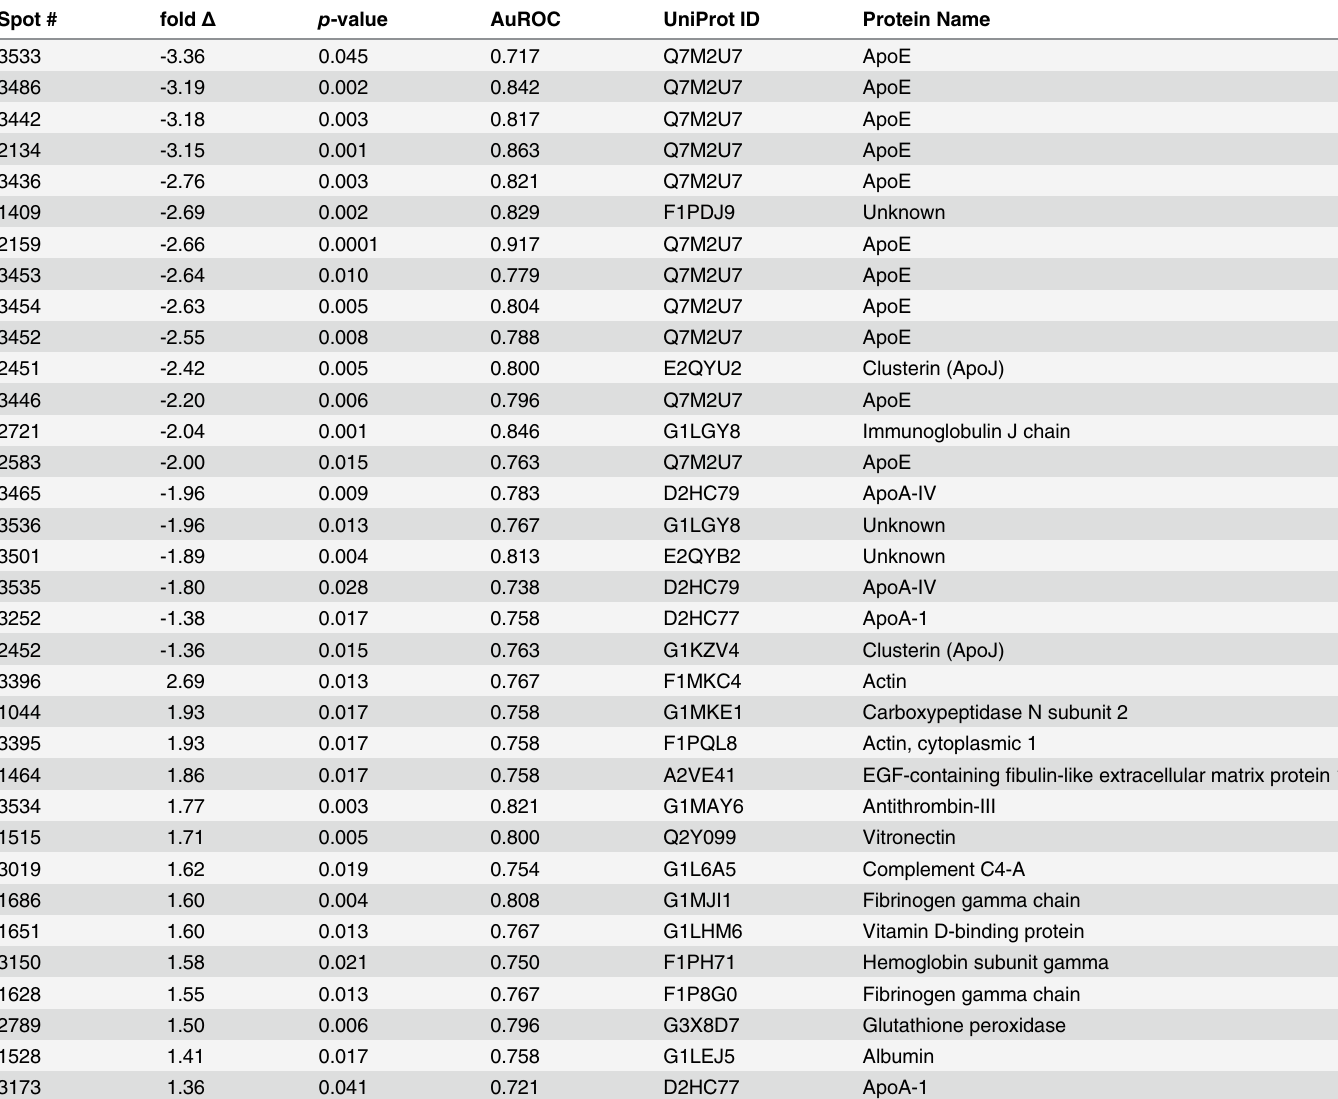
Table 3. Gel spot protein identifications and